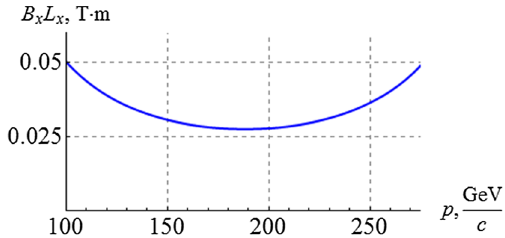
Fig. 6 Dependence of the field integral of a radial-field dipole on the beam momentum when stabilizing ν nav = 0 . 01